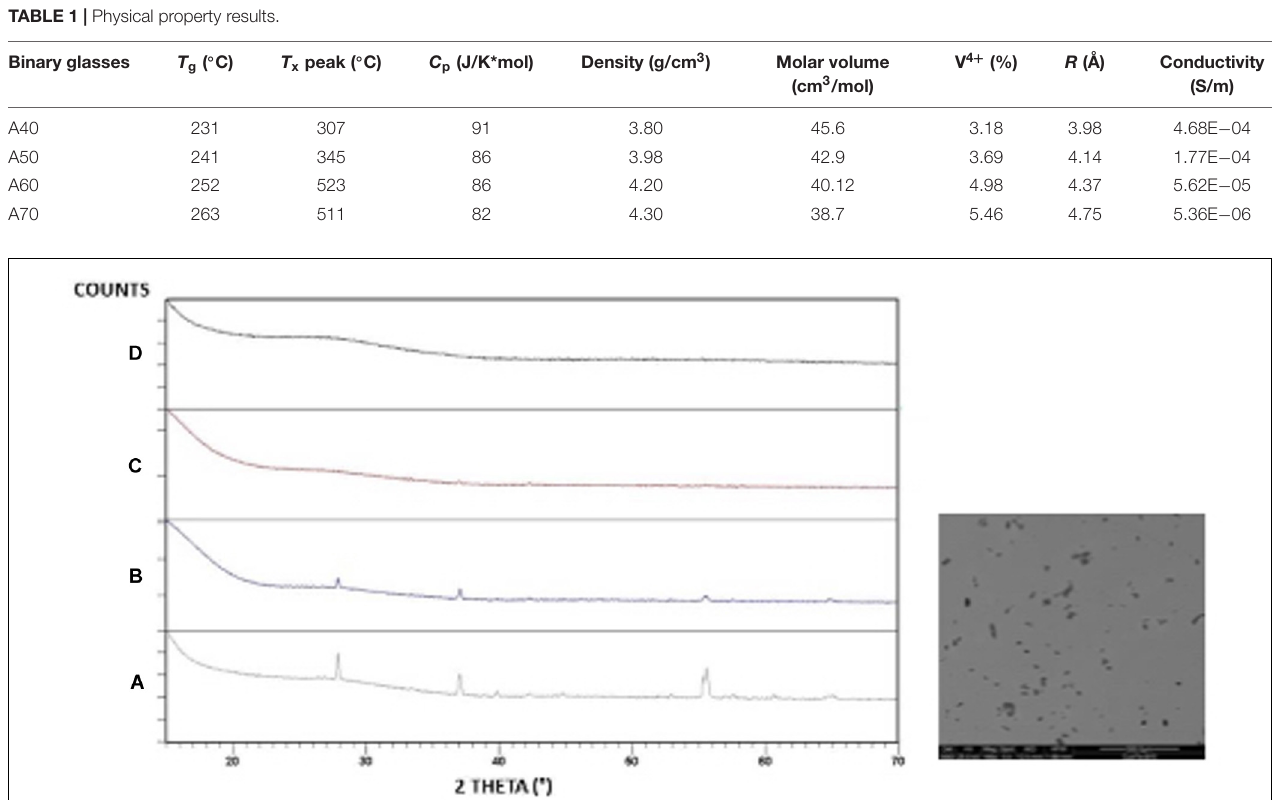
FIGURE 1 | XRD patterns of B-serier glassses: (a) B15 and SEM IMAGe (b) B10 (c) B05 (d) B025 from (a) to (d) the amount of Te decreases.